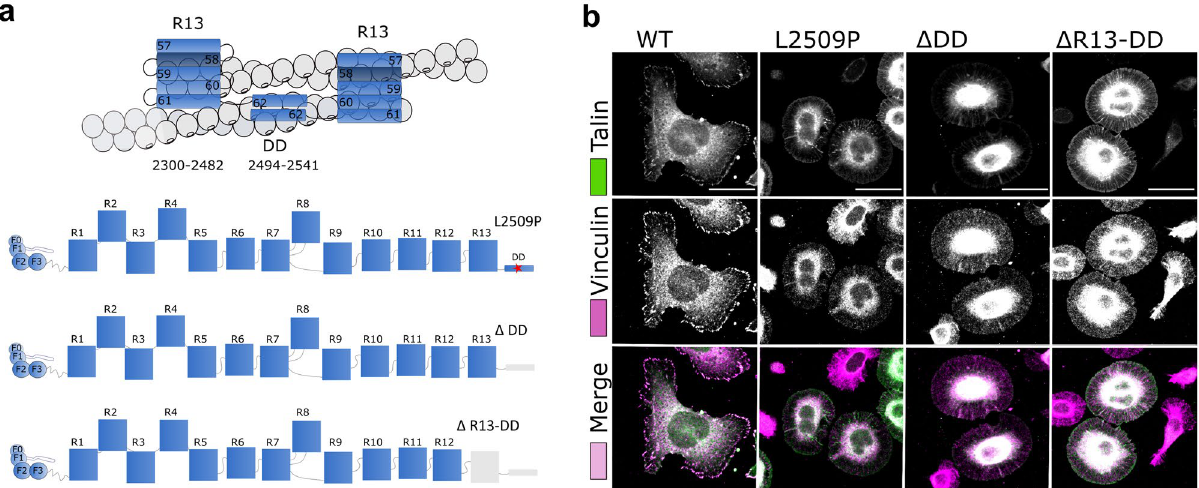
Figure 5. The point mutation L2509P has the same effect on cell morphology as the deletion of the whole dimerisation domain. ( a ) Cartoon of the R13–DD bound to actin (top) and schematic representations of the point mutation L2509P in full-length talin and the truncations; ΔDD and ΔR13-DD. ( b ) SUM projections of z–stacks of TLN1 –/– TLN2 –/– mouse kidney fibroblast cells expressing WT, L2509P, ∆DD, ∆R13–DD talin